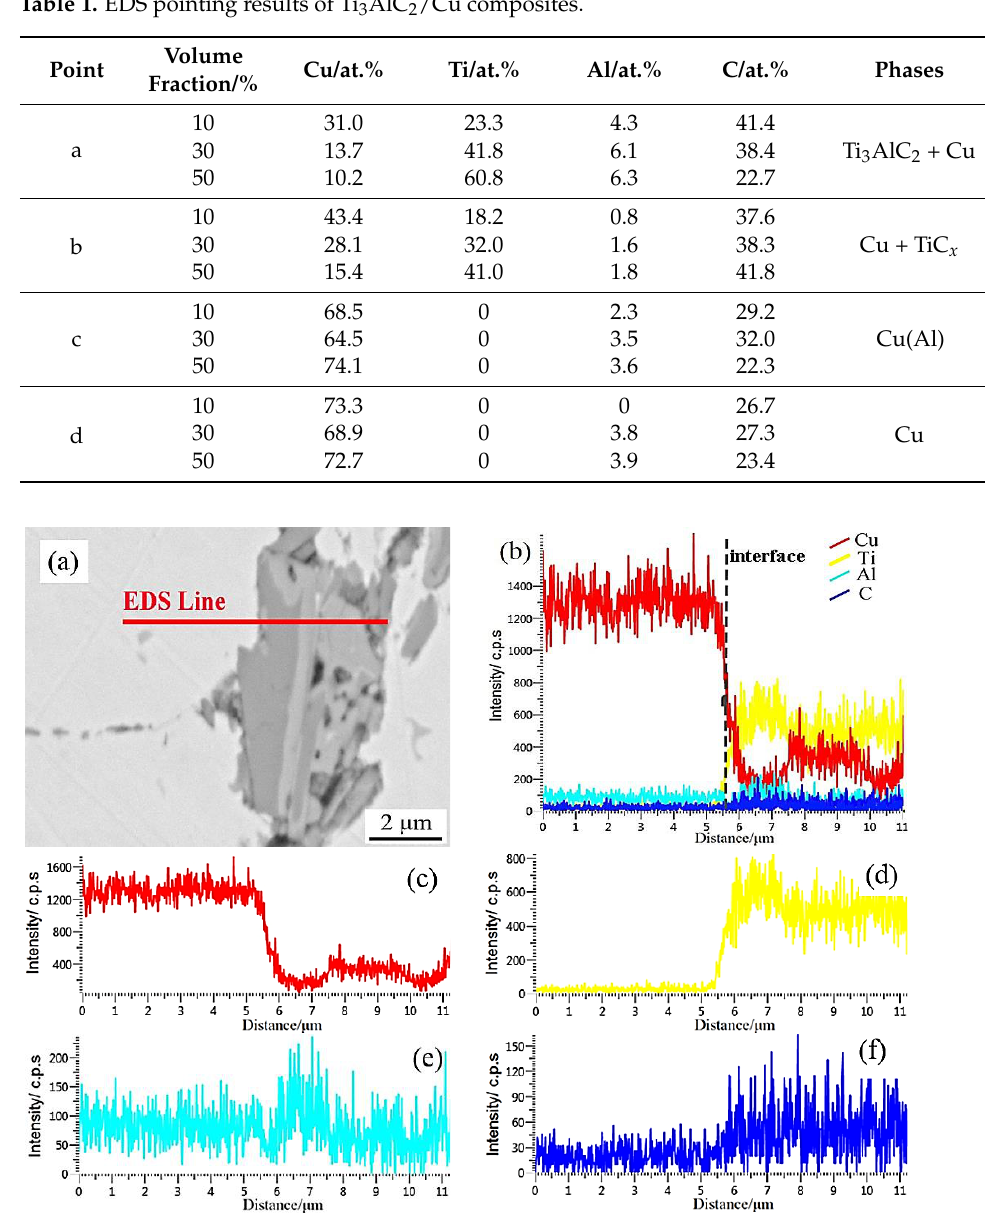
Figure 6. EDS lining of Ti 3 AlC 2 /Cu composites when the volume fraction of Ti 3 AlC 2 is 50 vol.%: ( a ) the interface between Cu matrix and Ti 3 AlC 2 , ( b ) scanning results of all elements: ( c ) the Cu element, ( d ) the Ti element, ( e ) the Al element and ( f ) the C element.